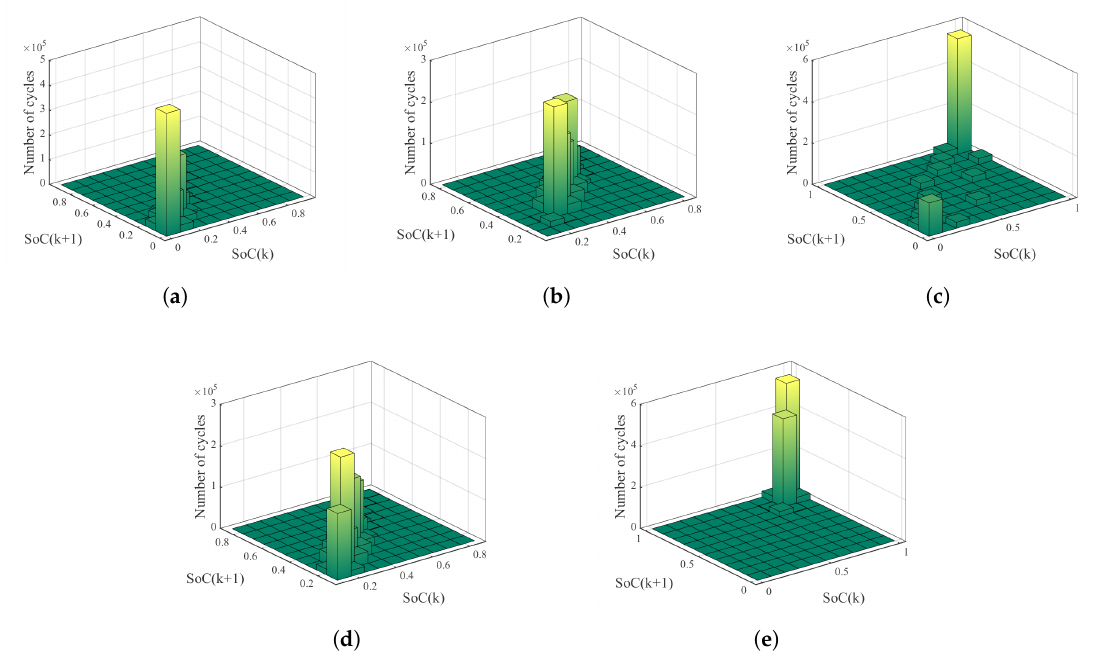
Figure 7. Number of cycles of the battery with respect to the SoC profile for the five considered strategies: ( a ) ElCo; ( b ) BaCo; ( c ) SmChCo; ( d ) BoCo; and, ( e ) LoDeCo.